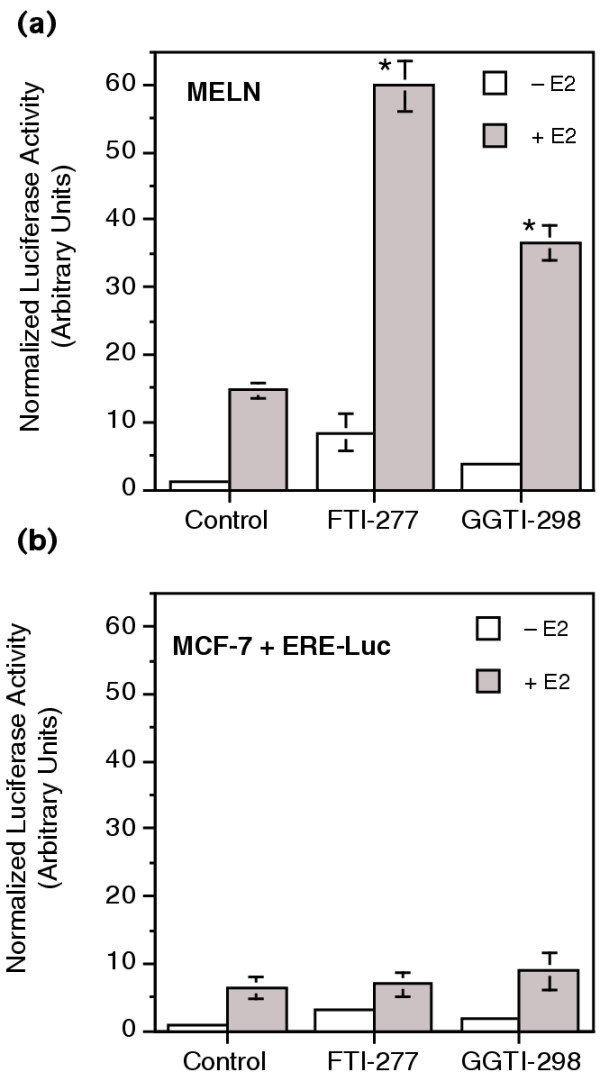
Effects of prenyltransferase inhibitors on estrogen response element (ERE)-dependent luciferase activity (a) in stably transfected MELN cells and (b) in transiently transfected MCF-7 cells. Both MELN cells and MCF-7 cells are deprived of estradiol (E2) for 4 days, and the MCF-7 cells are transiently transfected with the ERE-β-glob-Luciferase and the Renilla luciferase plasmids. Three hours after transfection, cells were treated or not with FTI-277 (10 μM or dithiothreitol/dimethylsulfoxide vehicle). Twenty-four hours later, cells were stimulated with E2 (5 nM) or ethanol and were treated or not with FTI-277 or GGTI-298 (10 μM or 5 μM, respectively, or dithiothreitol/dimethylsulfoxide vehicle). Luciferase activity was quantified 16 hours after E2 addition, as described in Materials and methods. Results are expressed in arbitrary units after normalization. Error bars indicate the mean values ± standard deviation from triplicate experiments, and the results are representative of two independent experiments. Results obtained show that prenylation inhibitors statistically increase the luciferase activity induced by E2 compared with the activity induced by E2 alone in MELN cells only (* P < 0.02).